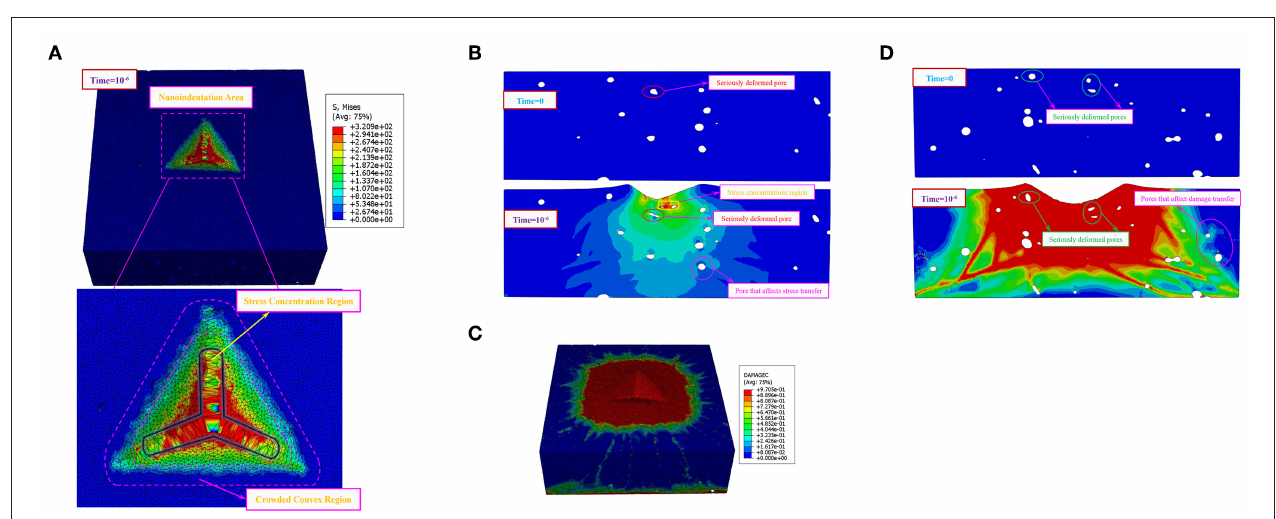
FIGURE 6 | The modified simulated nephogram of P 14 (A) the stress distribution of the model (B) the stress distribution of the middle section in the X direction (C) the distribution of the compressive damage of the model (D) the compressive damage distribution of the middle section in the Y direction.